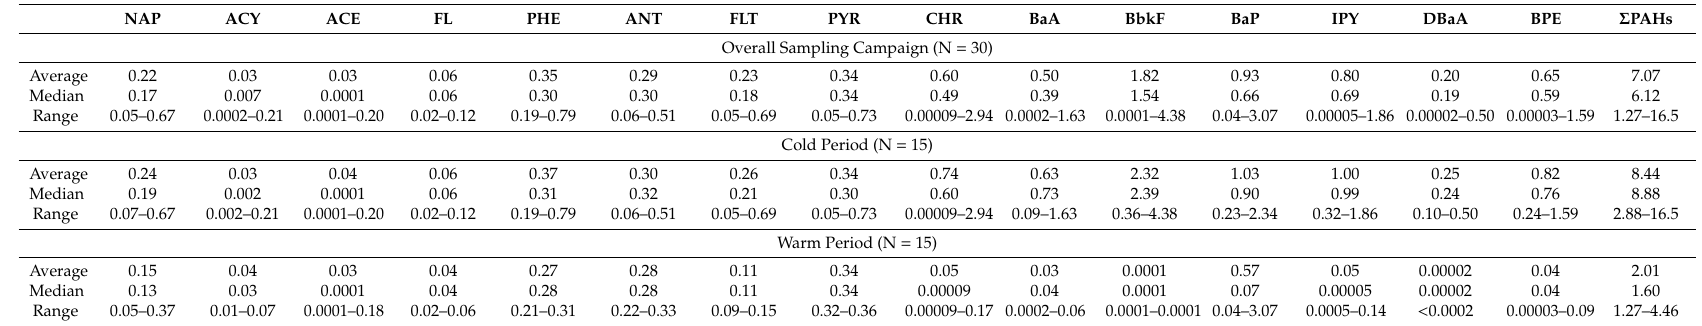
Table 1. Average, median, and ranged concentrations of polycyclic aromatic hydrocarbons (PAHs) (ng m − 3 ) for the overall and seasonally divided sampling